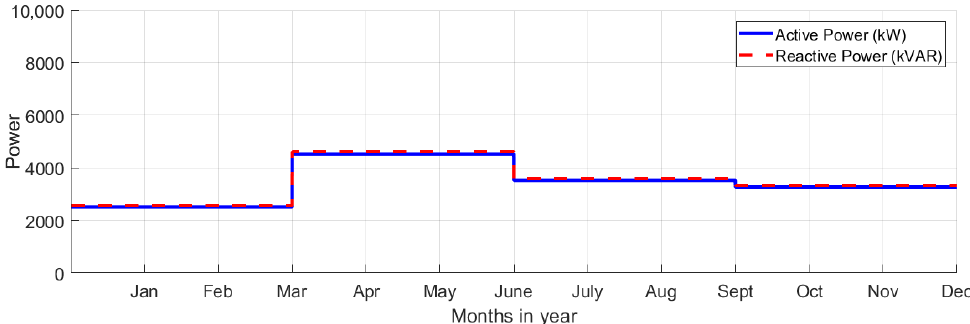
Figure 5. Seasonal load profile for N 2